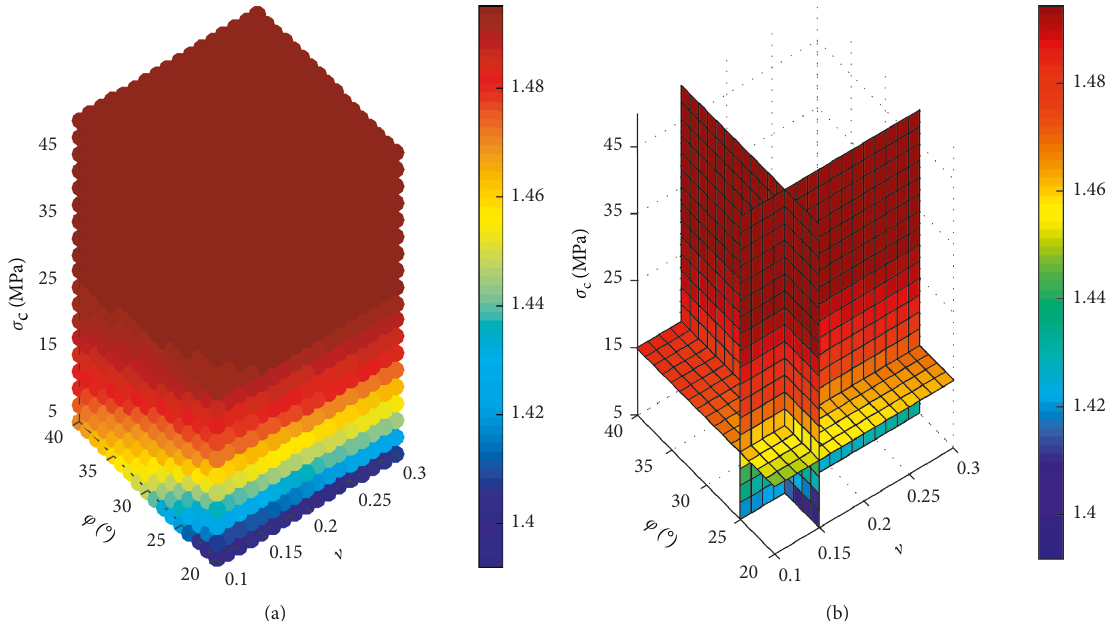
Figure 8: Interpolation of the loading coefficient b for E